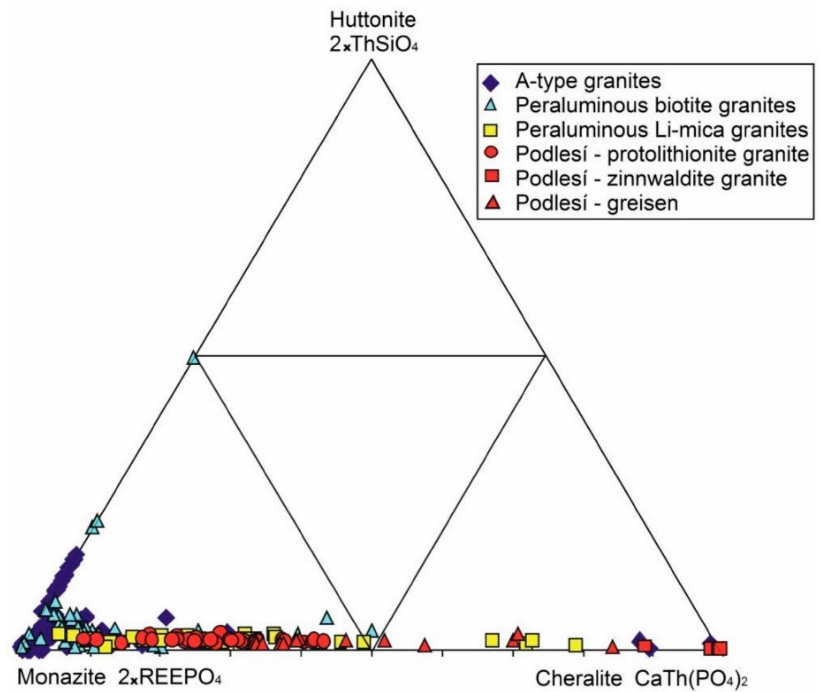
Figure 4. The monazite–cheralite–huttonite classification diagram after [25]. Li-biotite granite at the exocontact of the Podles í stock contains two chemical populations of monazite. One is identical with that described from protolithionite granite, while the other is poor in Th and U (5.5–9.5 wt% ThO 2 , equaling to 4–9% cheralite) but rich in La and Ce Chondrite-normalized REE patterns display, typically for monazite, a strong LREE enrichment with a deep negative Eu anomaly and predominantly moderate negative anomalies at La and Nd in all varieties of the protolithionite granite (Figure 5a,b). Monazite– cheralite s.s. from zinnwaldite granite and greisens are LREE-poor, with generally flat patterns and distinct kinks at La and Nd. Monazite from the surrounding Li-biotite granite is LREE-rich, with the majority of grains showing relatively low contents of La (Figure